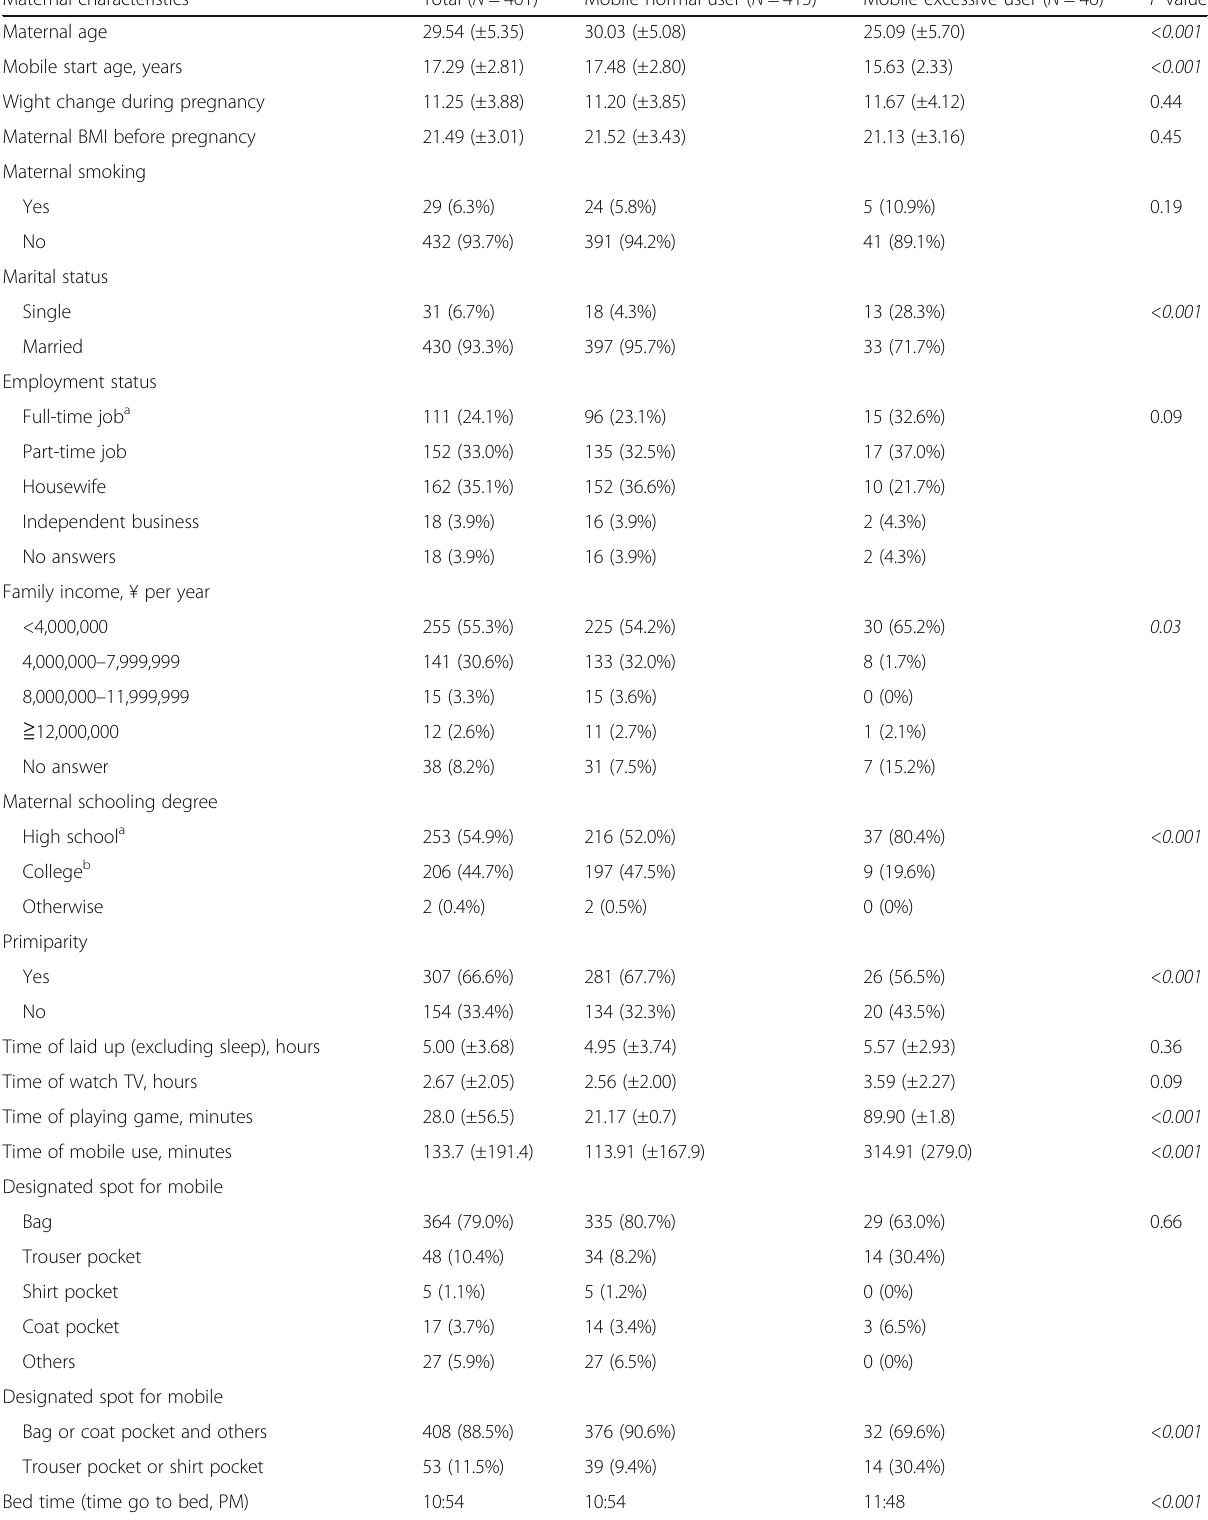
Table 1 Maternal characteristics and their differences between the normal and excessive use groups Maternal